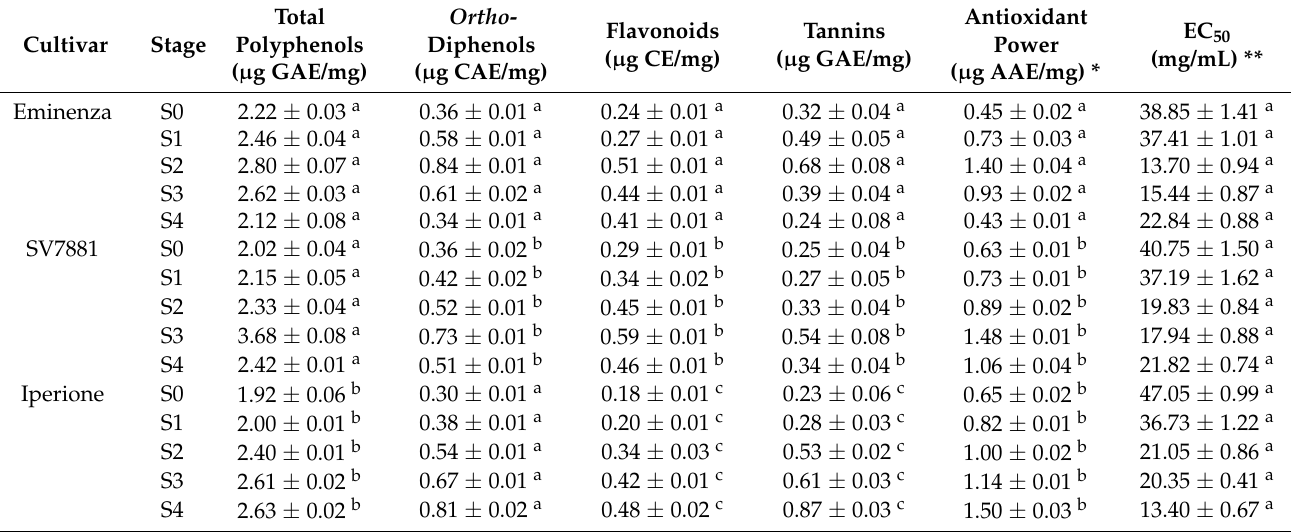
Table 2. Polyphenols, ortho -diphenols, tannins, flavonoids, antioxidants power, and EC 50 in Eminenza, SV7881, and Iperione during five ripening stages